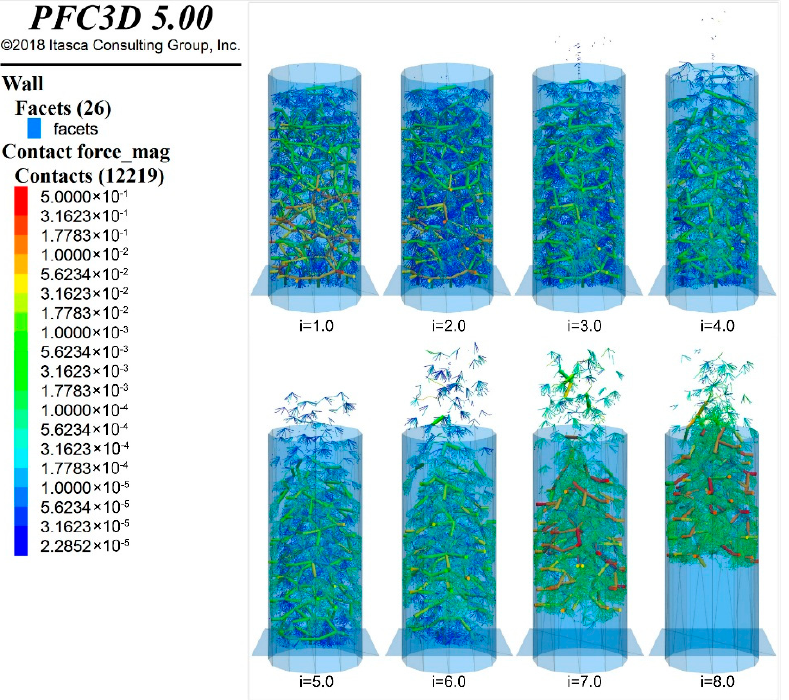
Figure 16. Evolution of contact force under different hydraulic gradients.